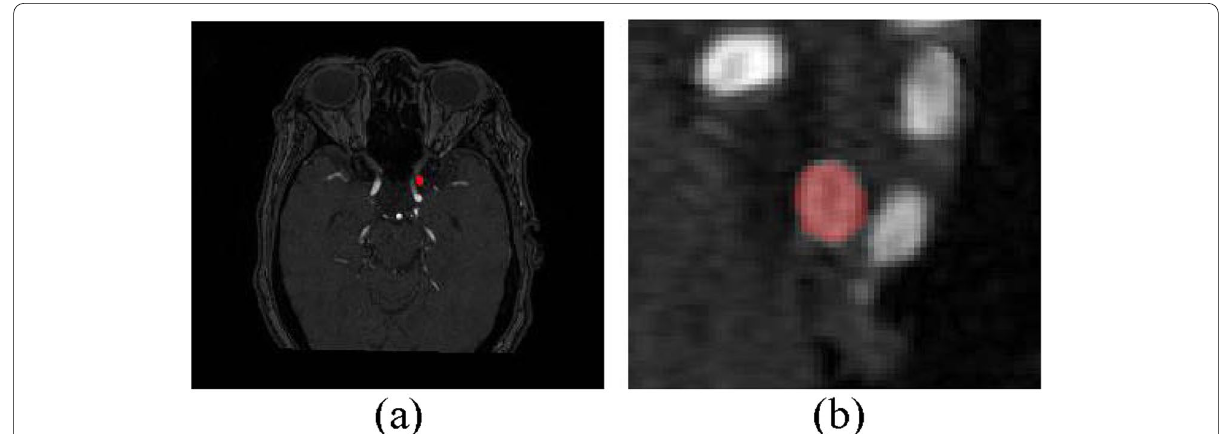
Fig. 1 The intracranial aneurysm image and its ground truth. a Original 3D TOF MRA image of an intracranial aneurysm in the sagittal view, with the red marker indicating the aneurysm-containing region; b Image of the aneurysm after